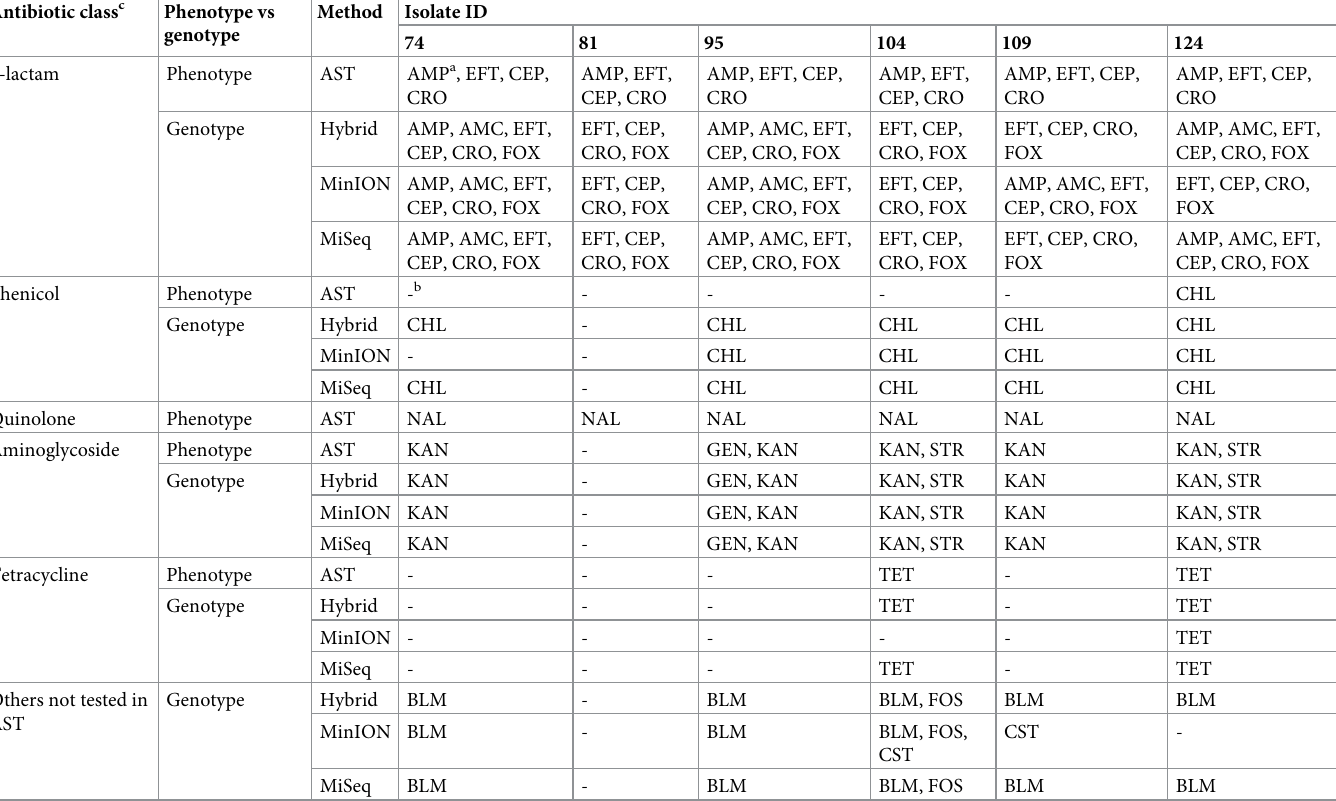
Table 4. Antimicrobial resistance (AMR) phenotypes of S . Enteritidis isolates, and their corresponding AMR genotypes, as predicted based on their hybrid, Min- ION, and MiSeq assemblies. Antibiotic class